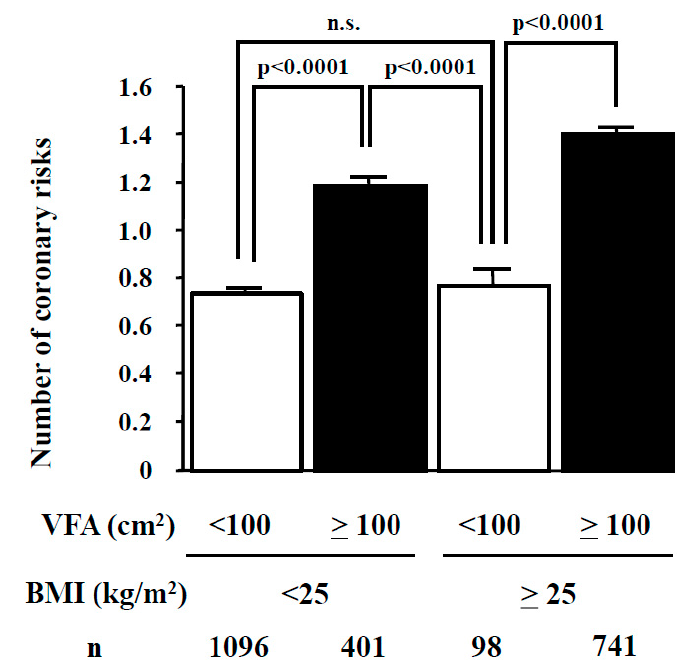
Figure 3. Relationship between number of metabolic risk factors and body fat distribution. Subjects were divided according to their BMI (cutoff value 25 kg/m 2 ) and VFA (cutoff value 100 cm 2 ). Data are mean ± SEM. BMI = body mass index; VFA = visceral fat area;. Data from Diabetes Care 2007; 30: 2392-94 [11], by permission of American Diabetes Association.